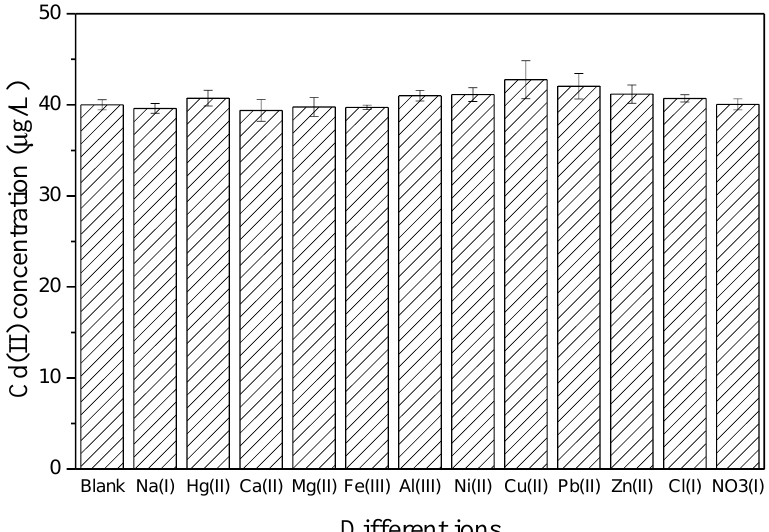
Figure 12. The 40 µg/L of Cd(II) before and after adding 50-fold concentrations of Na(I), Hg(II), Ca(II), Mg(II), Fe(III), Al(III), Ni(II), Cu(II), Pb(II), Zn(II) Cl(I), NO 3 (I). The error bars represent standard deviations based on three independent